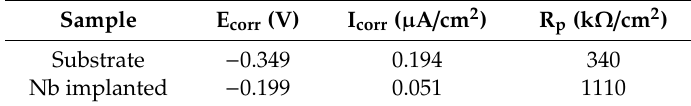
Table 2. Corrosion parameters calculated from the potentiodynamic polarization curves.